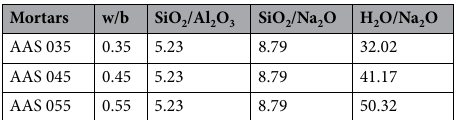
Table 2. Mix design for AAS mortars.